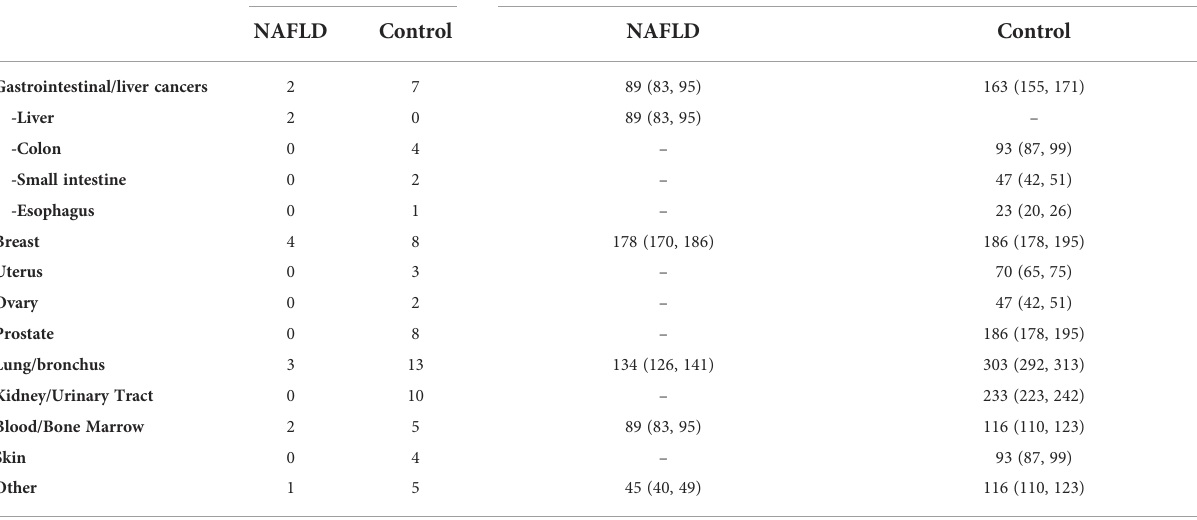
TABLE 2 Spectrum of cancers in NAFLD and